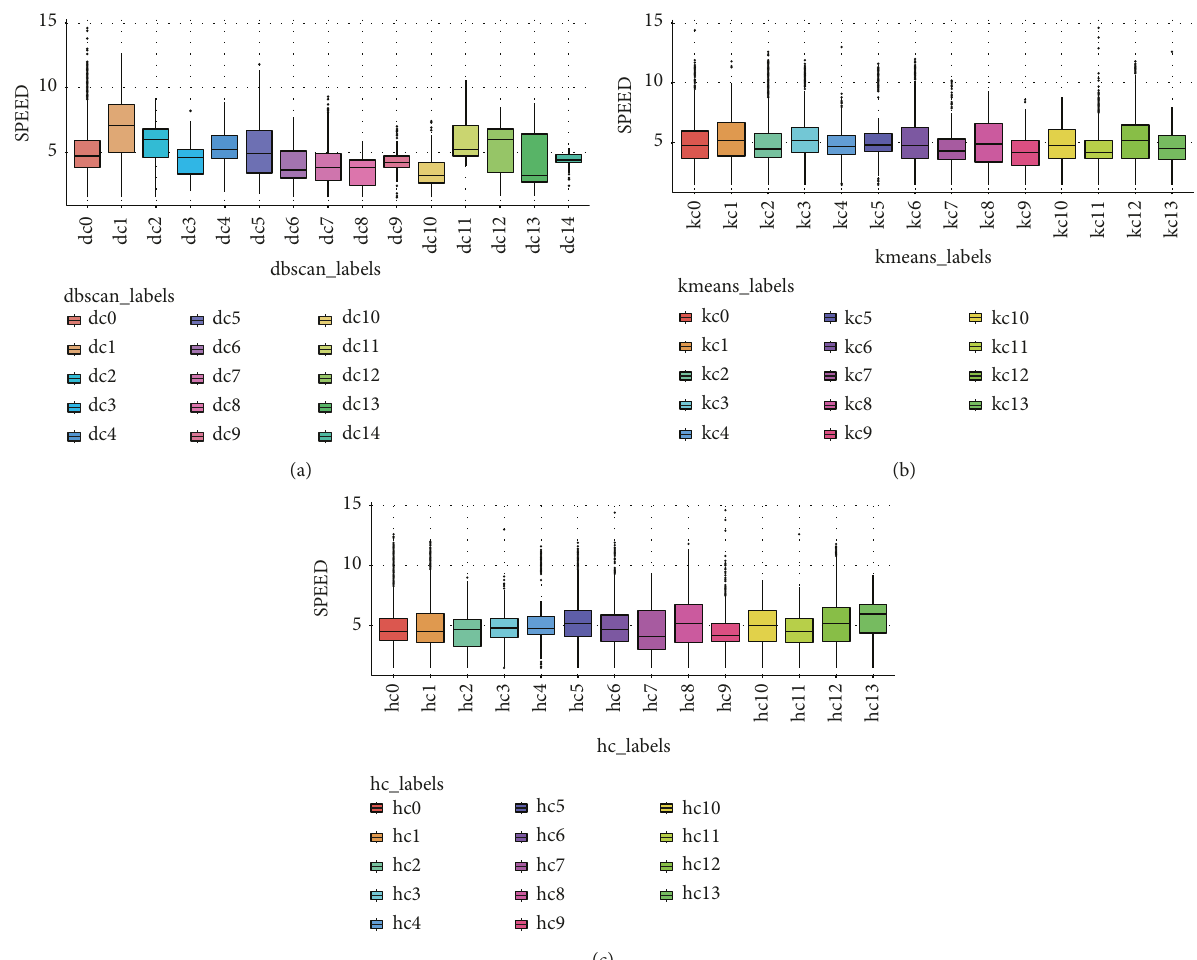
Figure 13: Speed distribution characteristics of (a) DBSCAN clusters; (b) K-means clusters; (c)